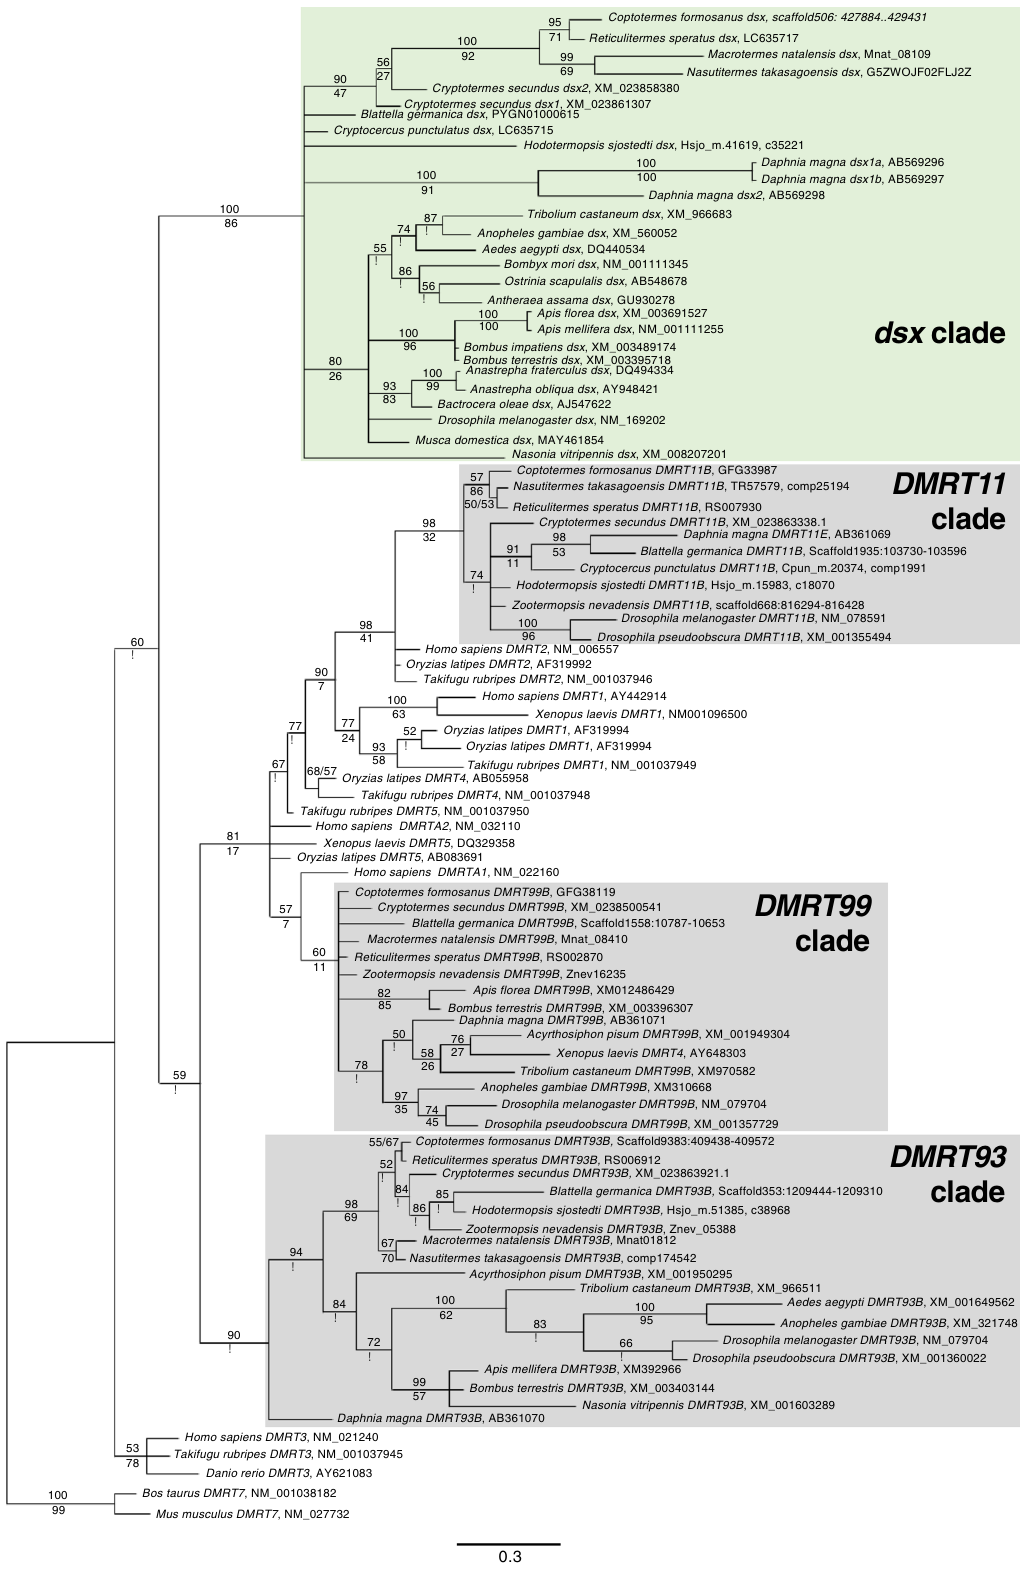
Figure 2. Molecular phylogenetic tree of dsx and DMRT homologues. Bayesian tree of dsx and DMRT of insects and crustaceans was constructed based on the OD1 sequences (135 bp with no gaps). Numbers shown above branches represent the Bayes posterior probabilities. Bootstrap values (1000 replicates) are shown below branches to indicate the level of support in the ML method. An asterisk indicates that a node is not supported by the ML